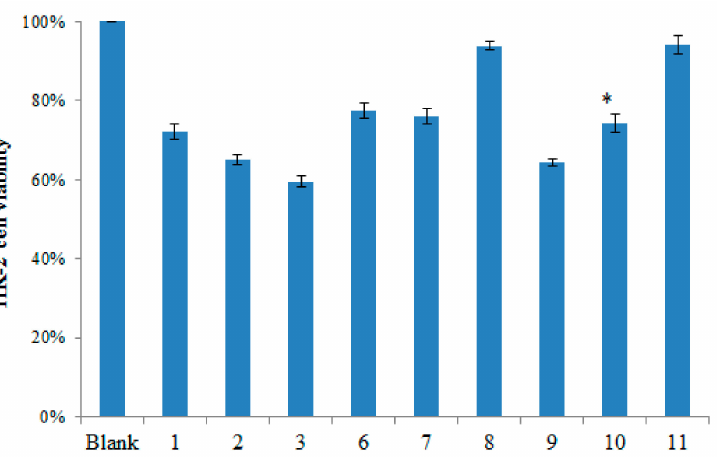
Figure 3. Cytotoxicity of the isolated compounds. HK-2 cells were treated with various aristolochic acid (AA) derivatives for 24 h, and then cell cytotoxicity was detected by the MTT assay. Student’s t-test was used to assess differences between the treatment groups; p values < 0.05 were considered statistically significant (* ≤ 0.05, for compounds 9 and 10 compared with compound 3